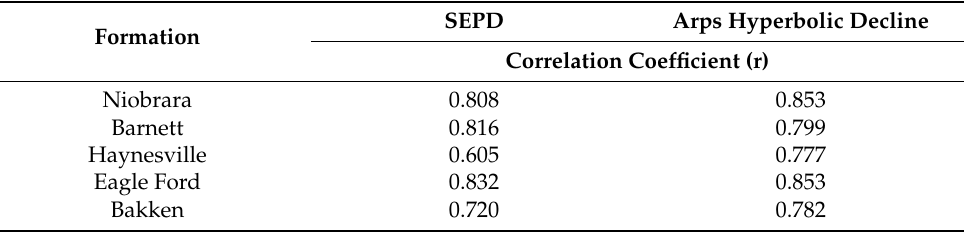
Table 9. Using average decline parameters error analysis in terms of correlation coefficient for all wells in each formation for the SEPD and Arps hyperbolic decline